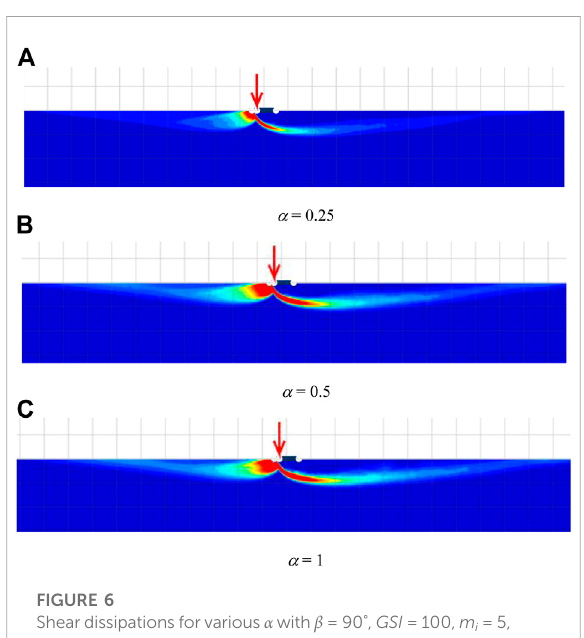
FIGURE 6 Sheardissipationsforvarious α with β =90 ° , GSI =100, m i =5, γ B/ σ ci = 0, and e/B = 0.3. (A) α = 0.25 (B) α = 0.5 (C) α =